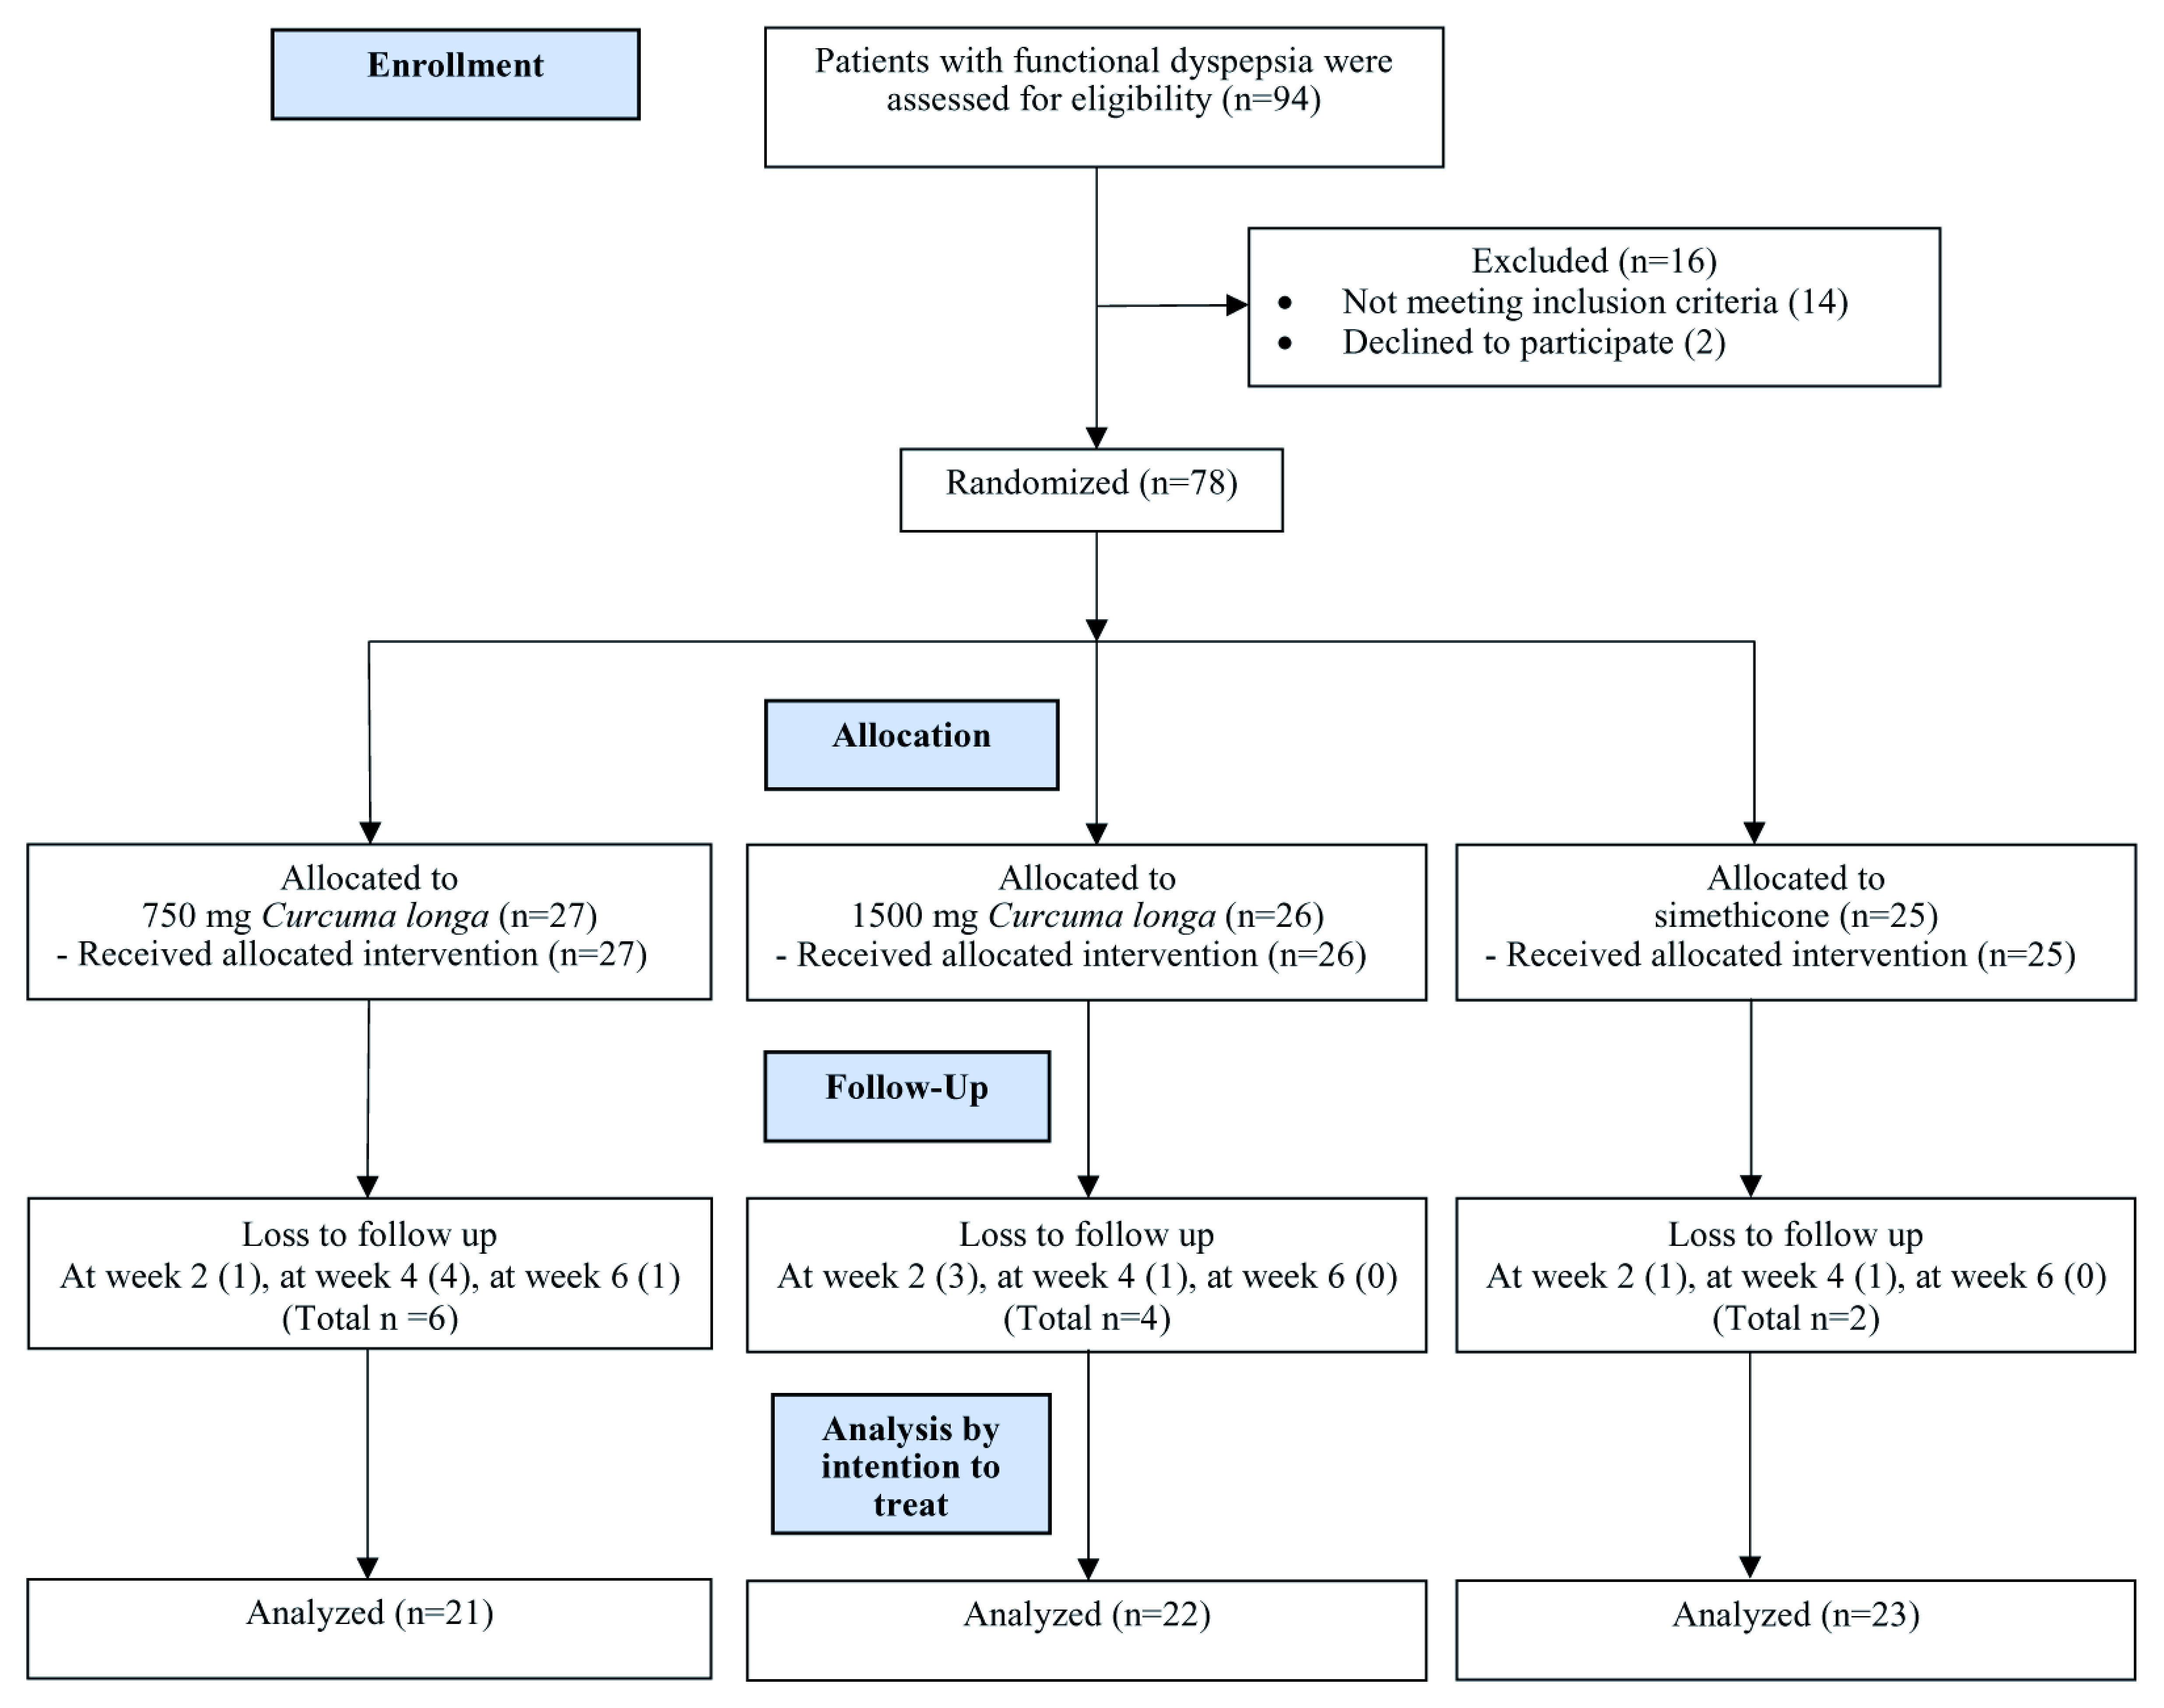
CONSORT diagram.